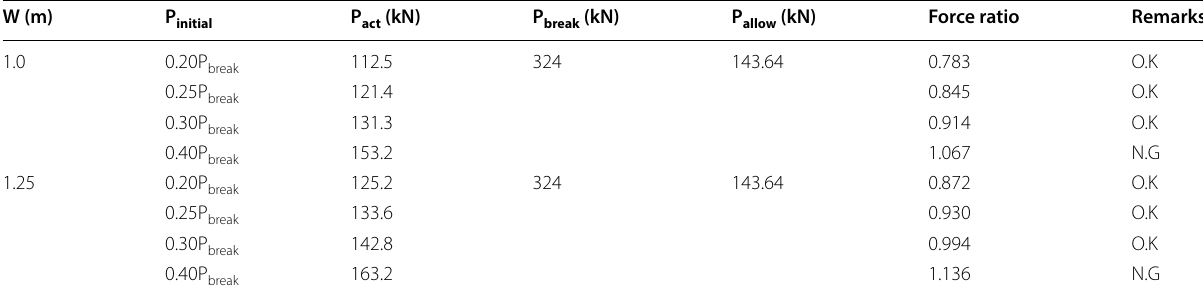
Table 6 Force ratio of the cable.